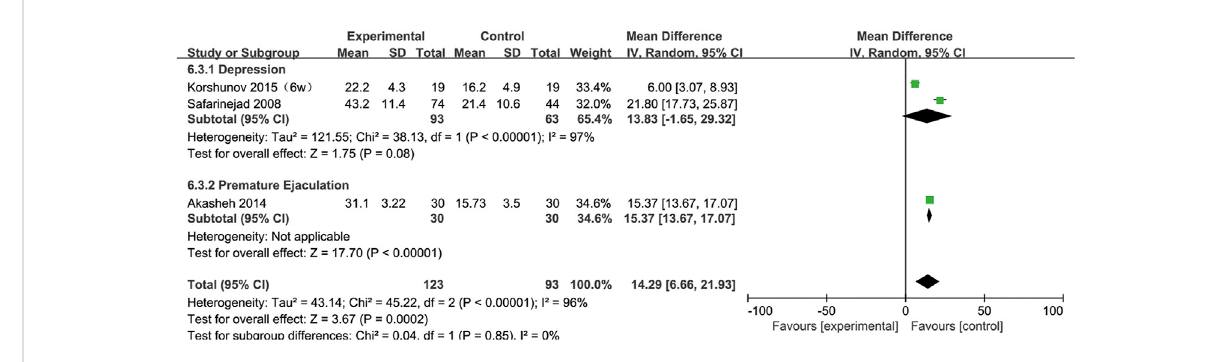
FIGURE 12 Subgroup of the association between sperm DFI and different basic disease.